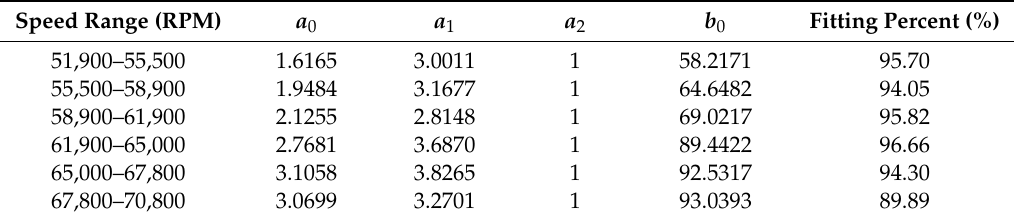
Figure 8. Rotation speed and the duty cycle of pulse width modulation (PWM). Table 2. The estimated parameters of the engine model at specific speed ranges.